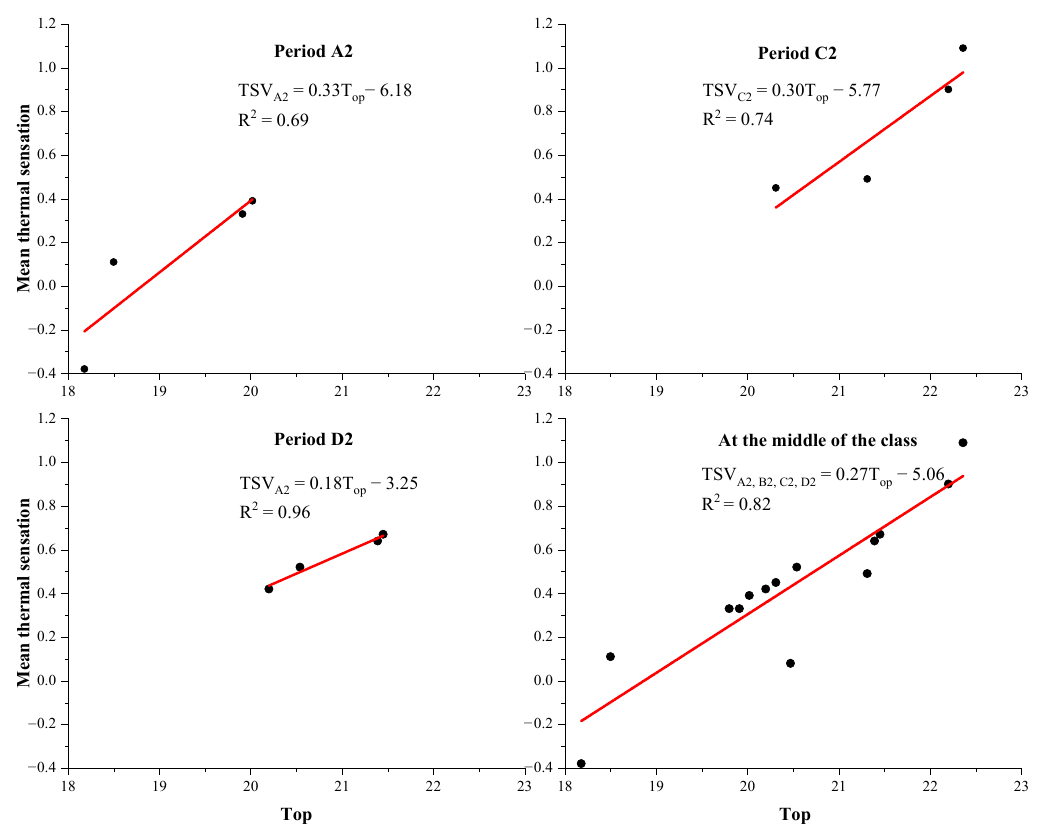
Figure 12. Relationship between TSV and operative temperature. Note: Owing to the insufficient sample size of periods B1 and B2, the data of the two periods were not analyzed.